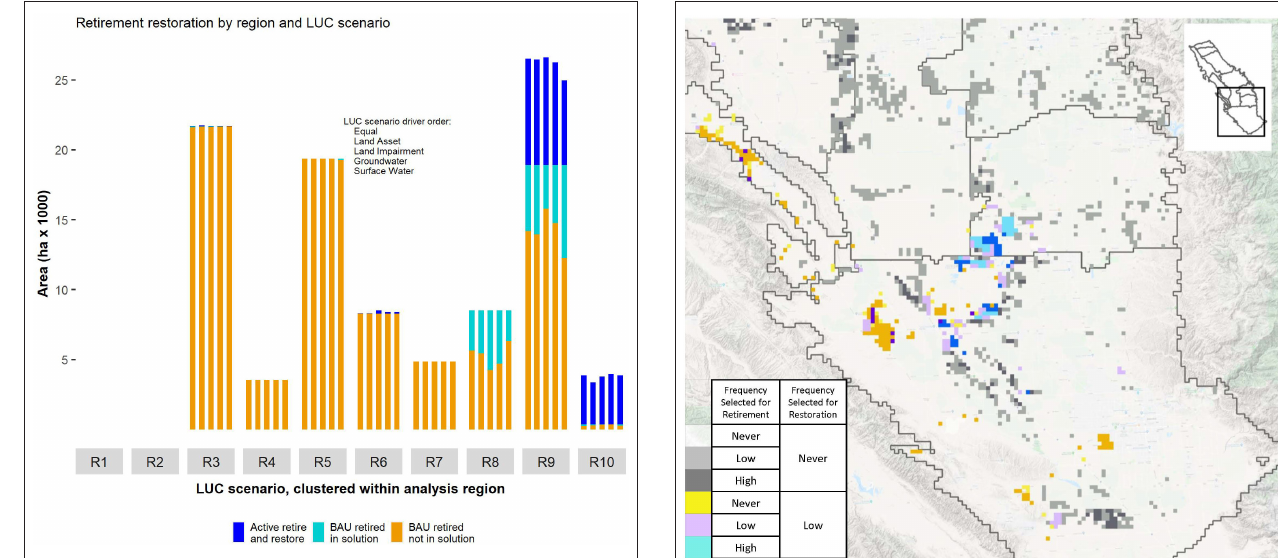
FIGURE 5 | Retirement and restoration by class, region, and LUC spatial scenario. “BAU retired in solution” refers to land identified for restoration that is projected to be retired even in the absence of strategic coordination. “Active Retire and Restore” refers to land identified for restoration that would otherwise remain in production under the BAU scenario, and would require active coordination to bring under restoration—possibly by working to prevent retirement of lower habitat value parcels “in exchange” for accepting the retirement of the high-priority parcel. “BAU retired, not in solution” is land that is projected to be retired and not targeted for restoration. Each region contains five bars corresponding to each land use change scenario, in the order overlayed on the plot (no retirement or restoration is predicted or selected in R1 and R2). Overall, the magnitude and relative proportion of each land use type are generally consistent across scenarios, with modest sensitivity to the amount and distribution of BAU-retired land in the solution across R8 and R9.